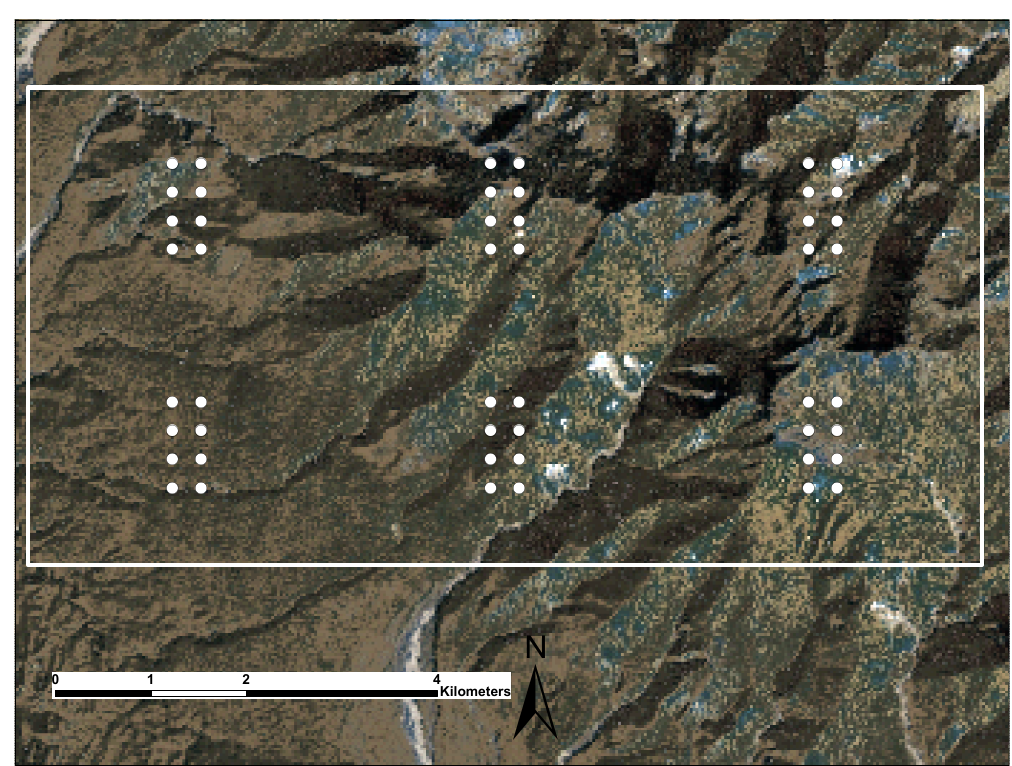
Figure 2. Sampling design: LiDAR block with six clusters of eight field plots